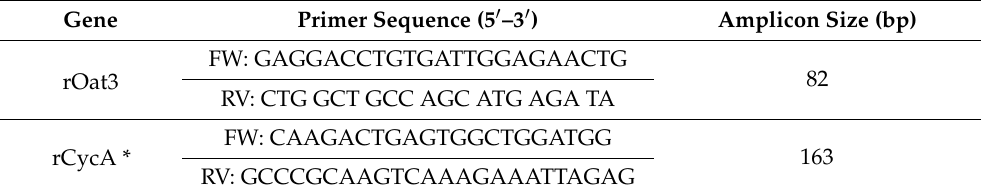
Table 3. Cont. Gene Primer Sequence (5 (cid:48) –3 (cid:48)